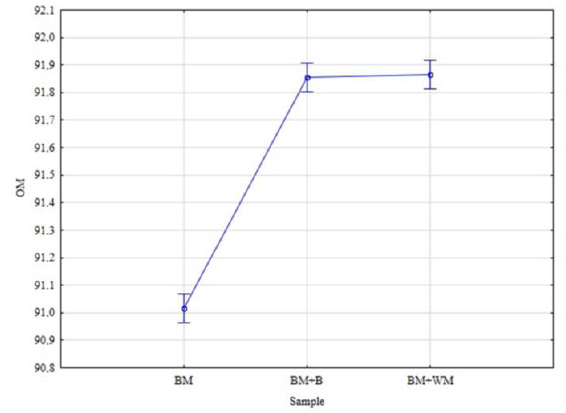
Figure 6. Mean contents of organic matter (OM) in BSG.